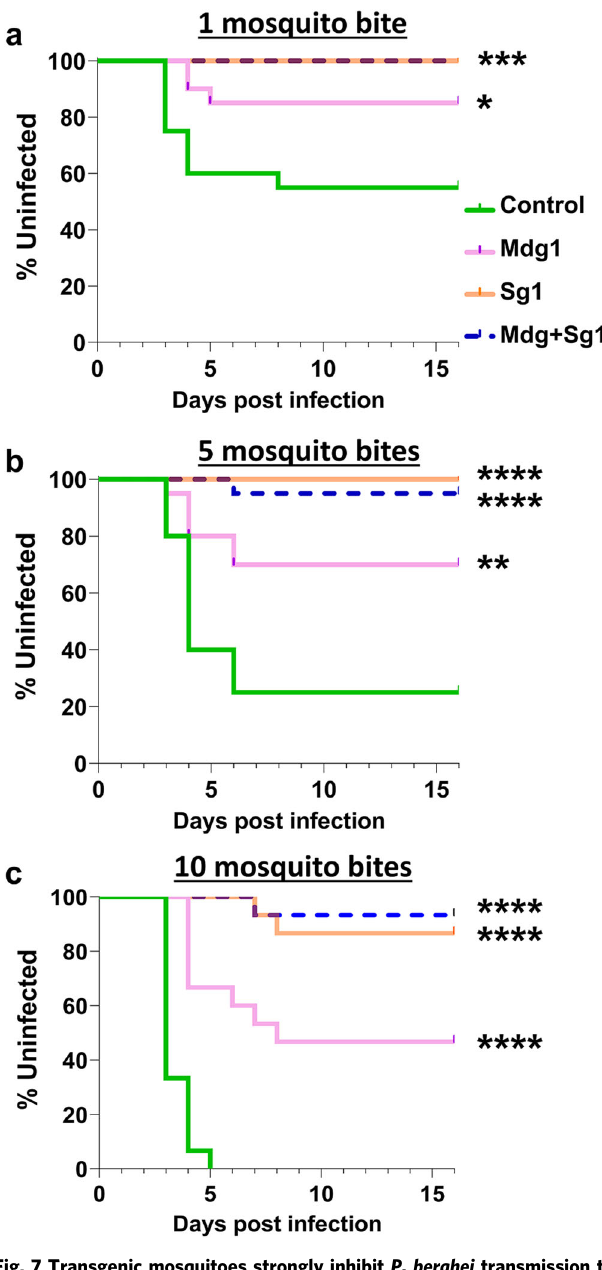
Fig. 7 Transgenic mosquitoes strongly inhibit P. berghei transmission to mice. a – c WT and transgenic mosquitoes were fed on the same P. berghei infected mouse, and unfed mosquitoes were removed. To determine their potential to transmit malaria, mosquitoes were randomly selected at 21 days post-infection and fed on naïve mice (challenge). Each mouse was challenged with one ( a ), fi ve ( b ), or ten ( c ) mosquitoes. Infection was determined by daily monitoring blood-stage parasites on Giemsa- stained blood smears. Statistical analysis was determined by Log-rank (Mantel-Cox) test with α = 0.05 and k = 0.0166. Data from 1 and 5 mosquitoes, N = 10 mice per group per replicate, with two replicates (total 20 mice). Data from 10 mosquitoes, N = 15 mice, 10 mice per group for one replicate and 5 mice per group for the second